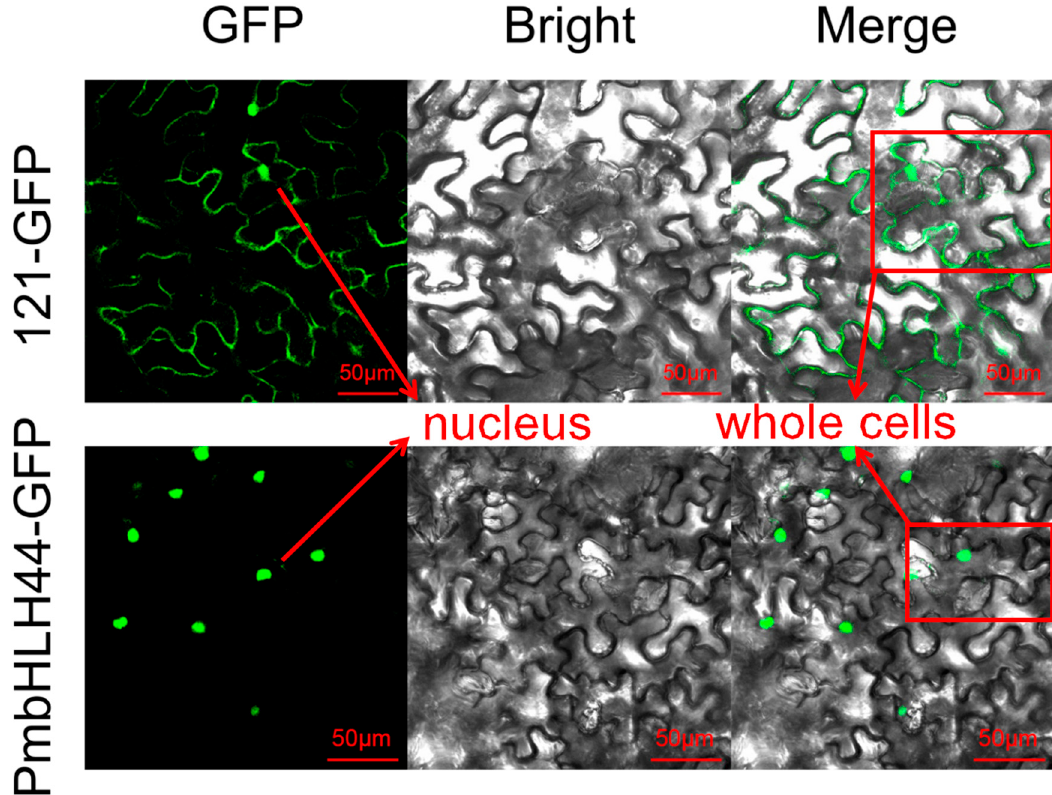
Figure 3. Subcellular localization assays of PmbHLH44 protein in tobacco leaf cells. Empty 121-GFP is localized in the whole cell, and 121-PmbHLH44-GEP is localized in the nucleus.